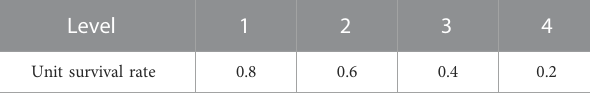
TABLE 2 DWT survival rate under different levels of stormy